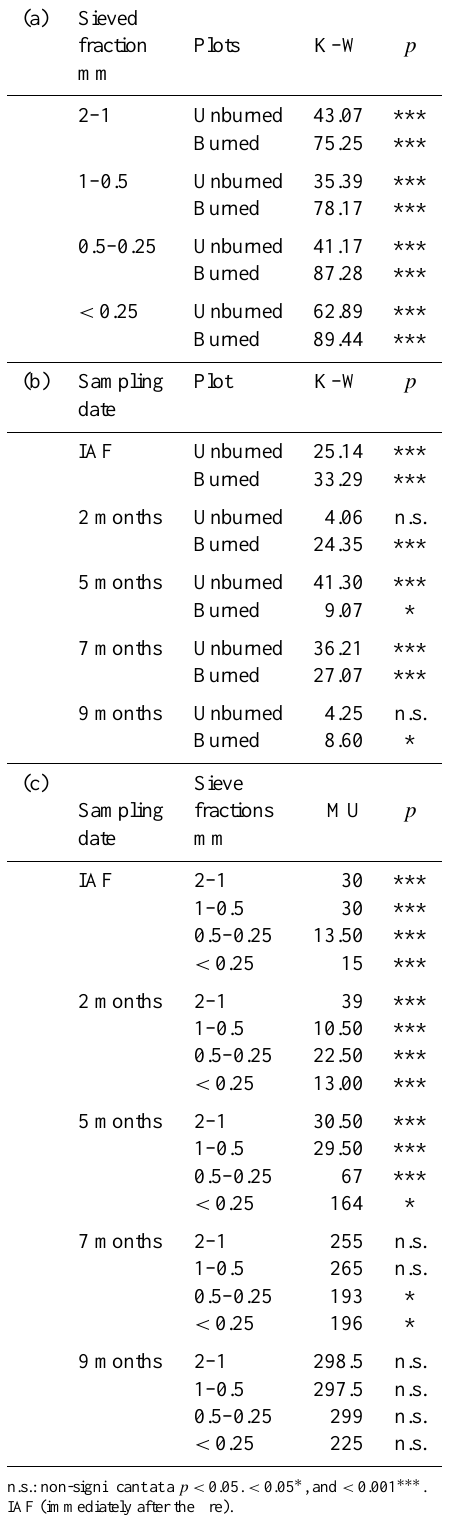
Table 3. Results of Kruskal–Wallis ANOVA and Mann–Whitney tests for SWR according to the analysed sieved fractions, (a) time, (b) soil sieved fractions in the same plot and (c) between plots in each soil sieved